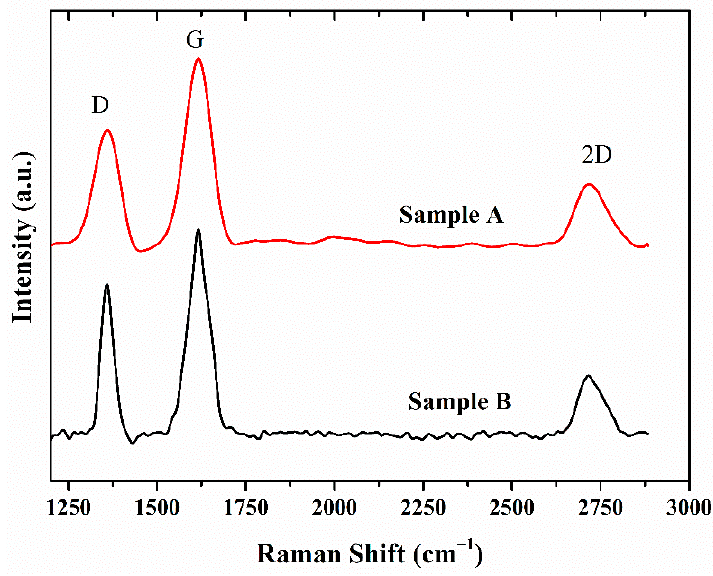
Figure 2. Comparison of Raman spectra of graphene synthesized by pure Ar (sample A) and Ar–N 2 mixture plasma (sample B).